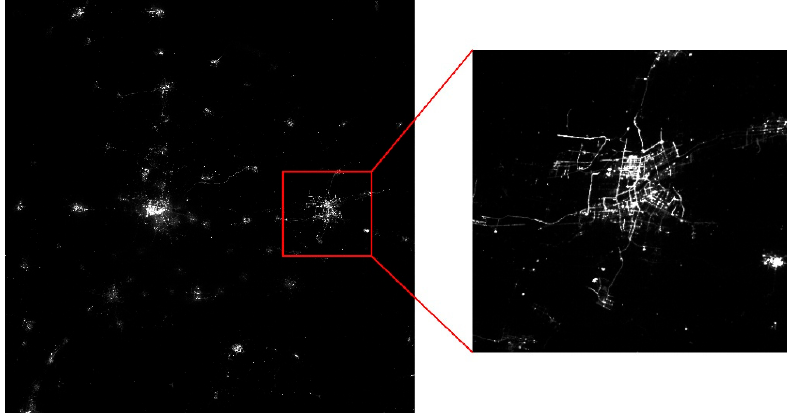
Figure 6. Modulation transfer function of the optical system.